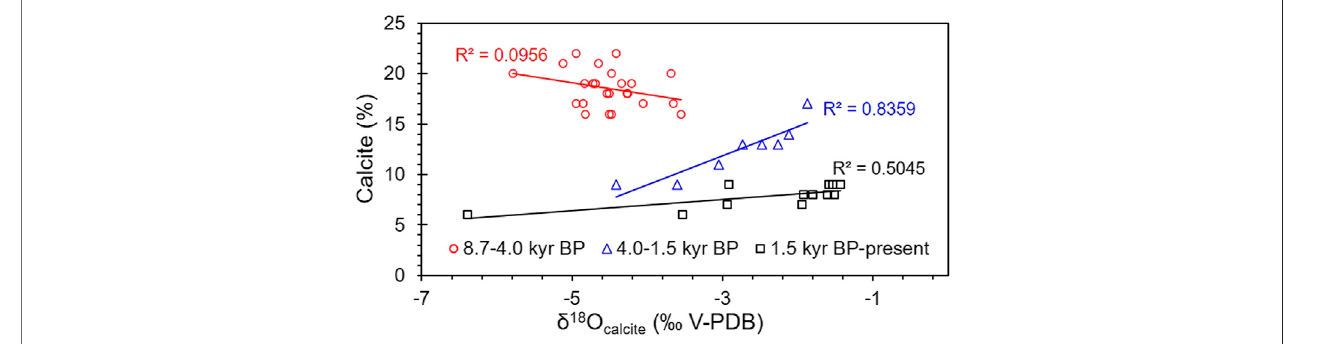
FIGURE 9 | Relationships between the calcite content and δ 18 O calcite ( ‰ VPDB) during the different periods.